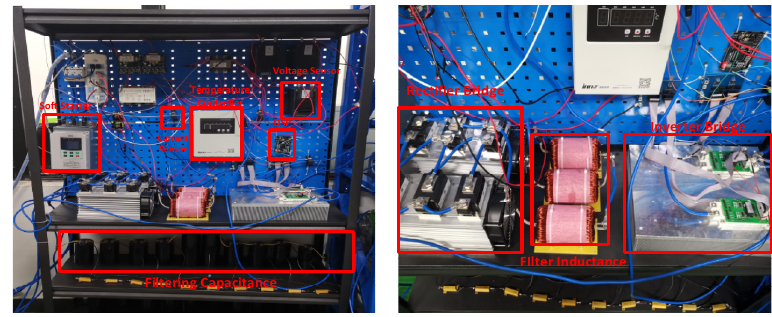
Figure 10. Experimental